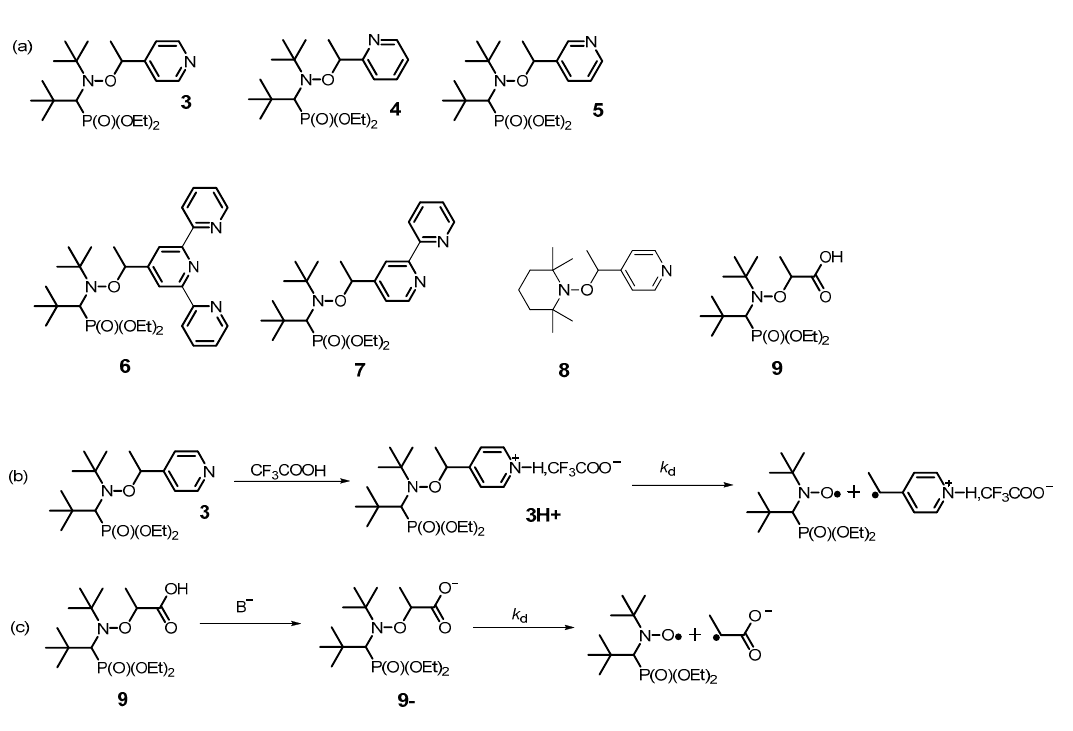
Figure 4. ( a ) Structures of alkoxyamines 3 – 9 ; (b ) Protonation of 3 and ( c ) deprotonation of 9 .